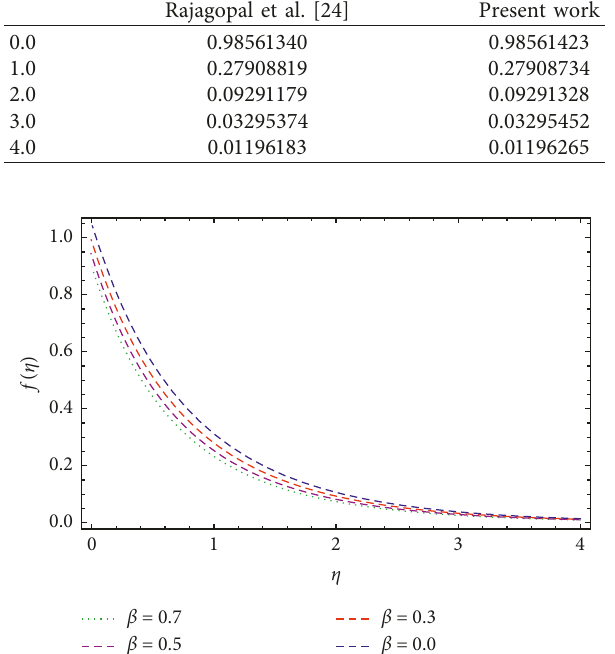
Figure 4: The influence of the velocity profile for different values of β , when K � 0 . 1 , f w � 0 . 3 , λ � 0 . 2 , Pr � 5 . 0 ,E c � 0 . 4 , and a ∗ � b ∗ � 0 . 2 .